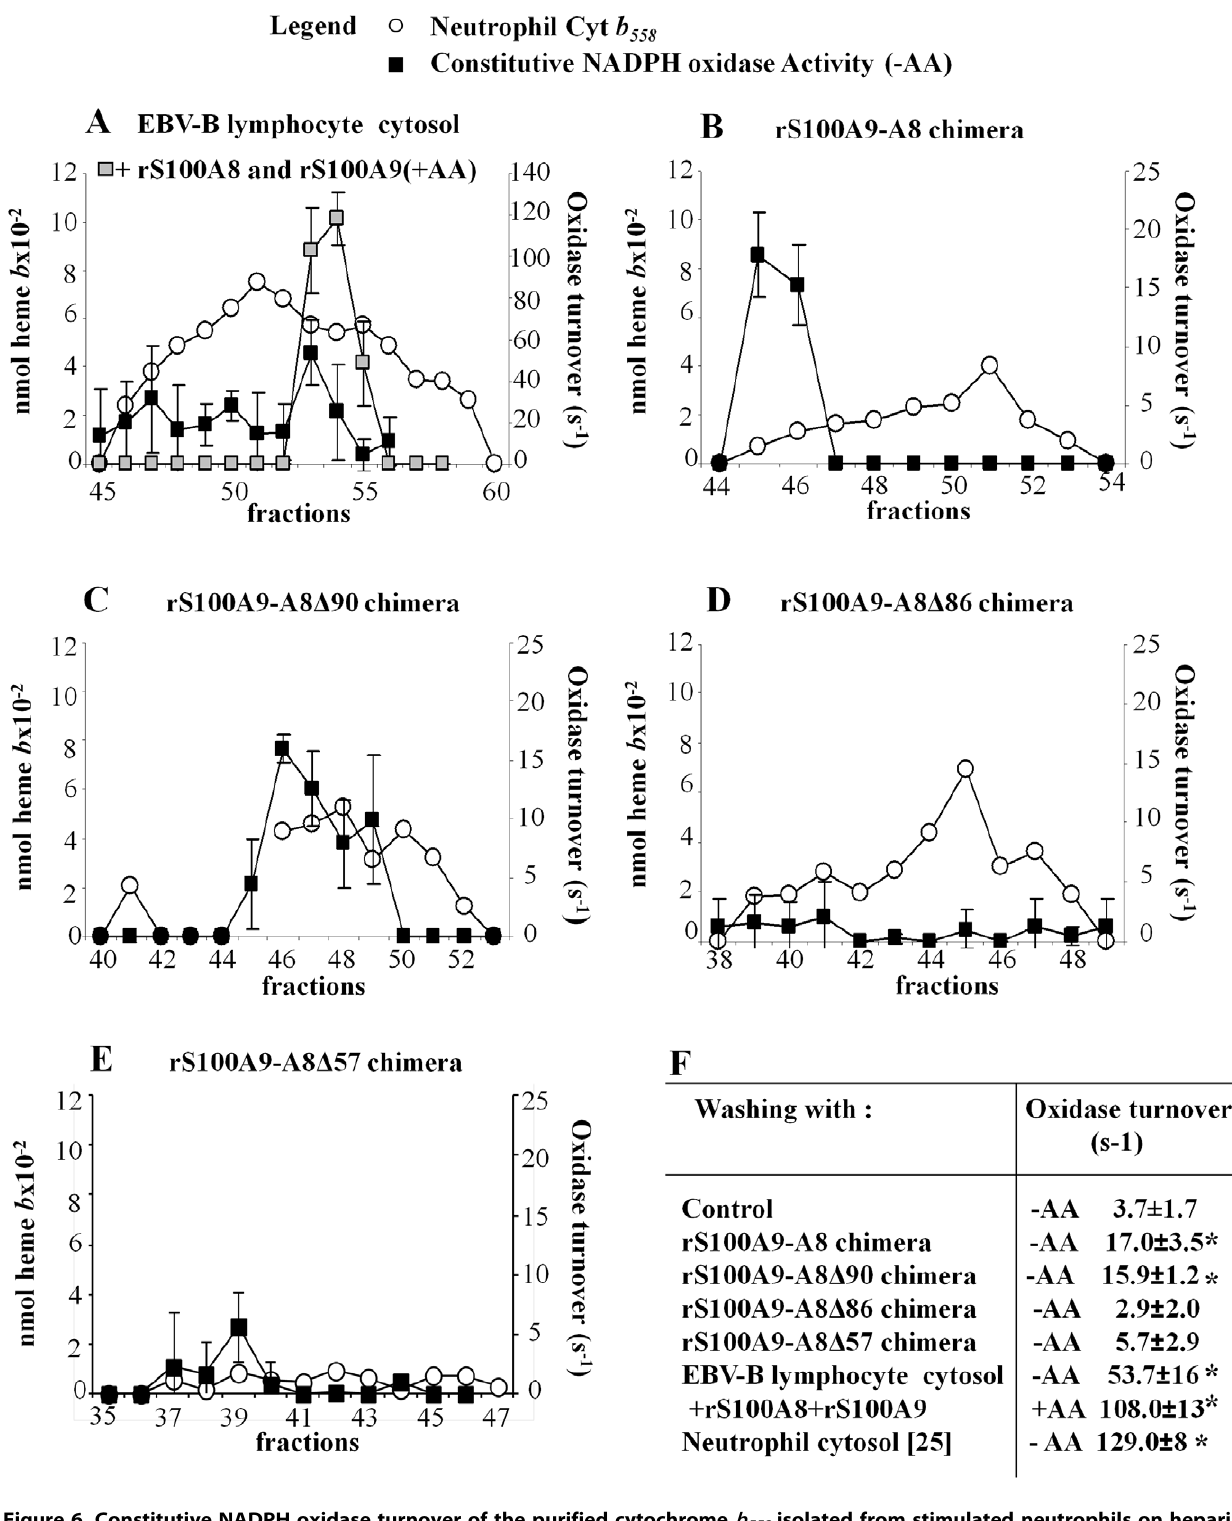
Figure 6. Constitutive NADPH oxidase turnover of the purified cytochrome b 558 isolated from stimulated neutrophils on heparin affinity matrix in the presence of rS100A9-A8 full length or truncated chimeras. Purification of cytochrome b 558 from stimulated neutrophils followed a standard protocol until it bound to the heparin affinity matrix as reported [25] and as described in Materials and Methods. The cytochrome b 558 bound to the affinity heparin matrix was washed with: (A) EBV-B lymphocyte cytosol; in some experiments, a 1/1 mixture of rS100A8 and rS100A9 was added to the Sephacryl eluted cytochrome b 558 and then the activity of NADPH oxidase was measured in the presence of (1 mM) arachidonic acid (grey square). (B) S100A9-A8; (C) S100A9-A8 D 90; (D) S100A9-A8 D 86; (E) S100A9-A8 D 57. S100 chimera proteins were preloaded with calcium (500 nM). After the washing step, eluted fractions containing cytochrome b 558 were pooled and filtrated on Sephacryl-S300. The concentration of cytochrome b 558 in the Sephacryl eluted fractions (open circle) was determined by measuring the ‘‘reduced minus oxidized’’